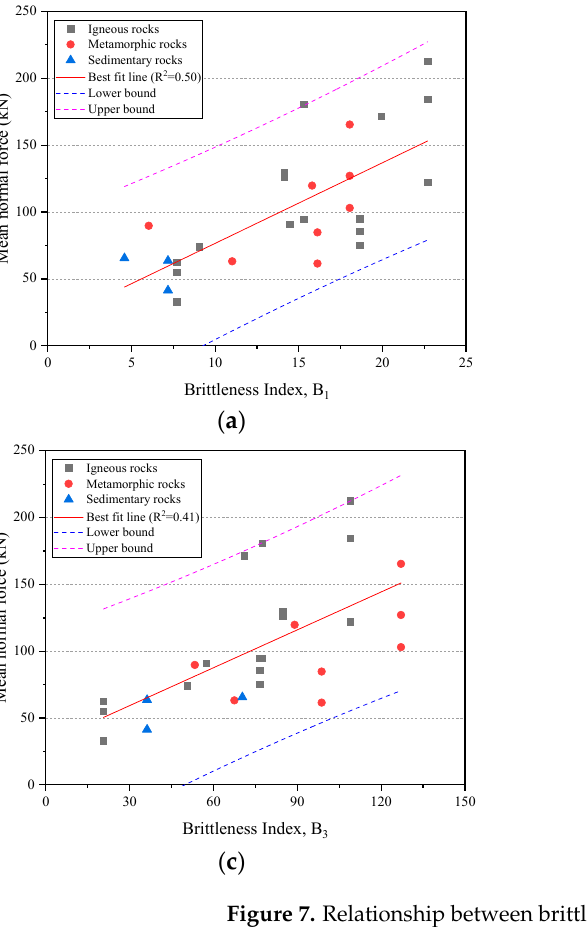
Table 5. Prediction models for normal cutter force.